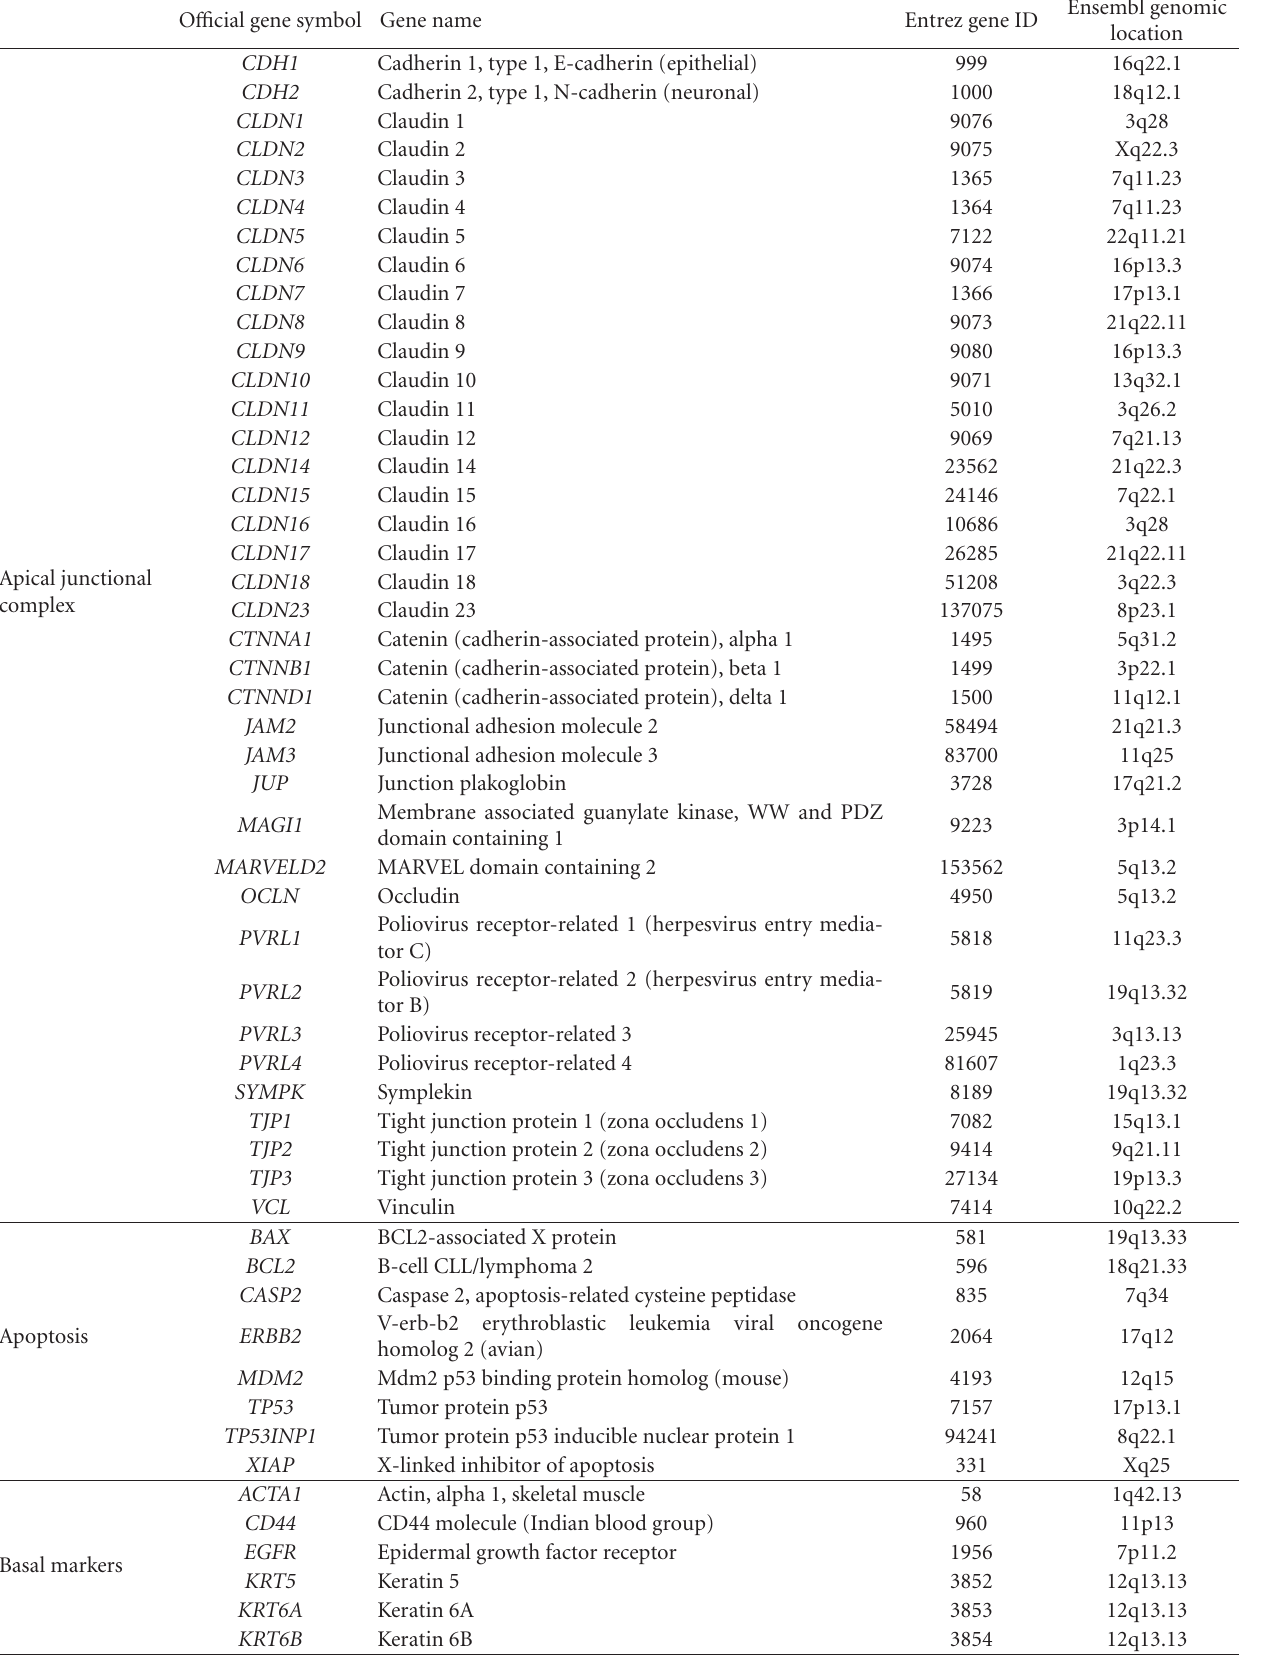
Table 1: Genes entered in the